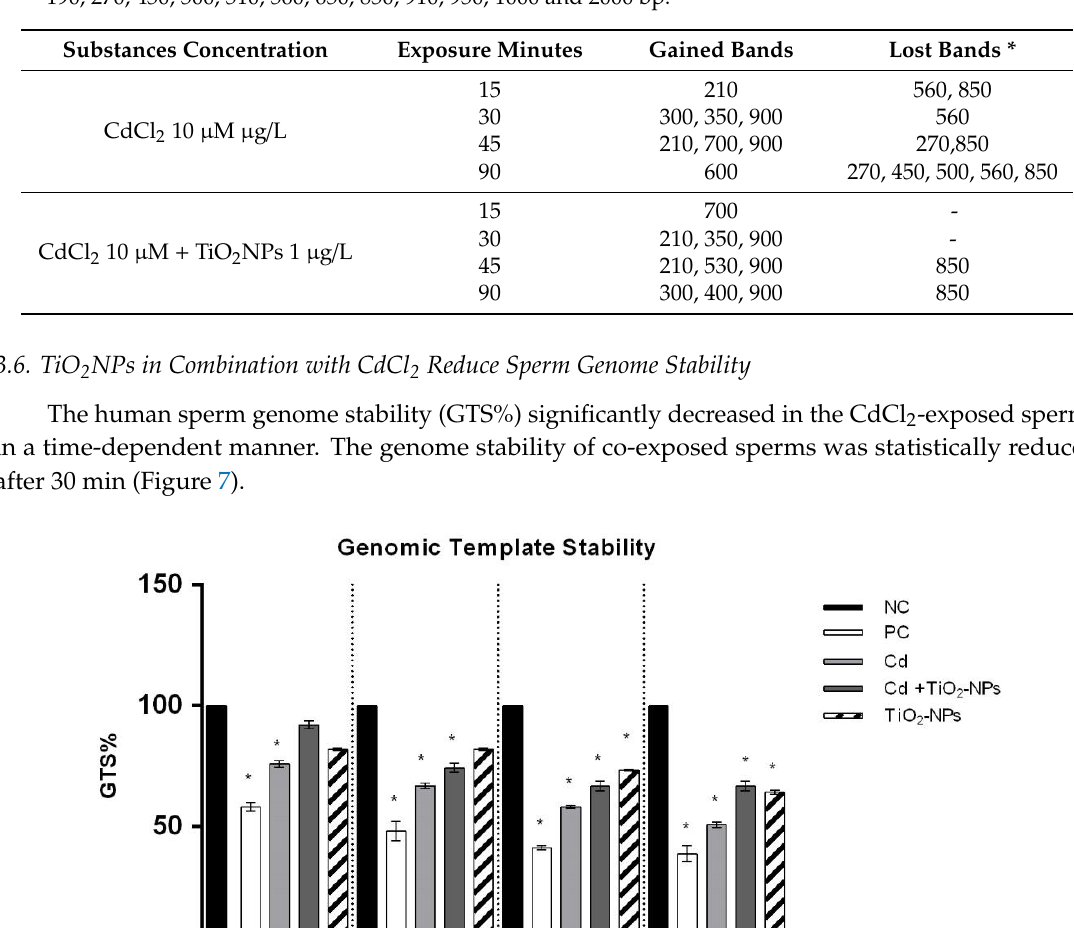
Table 4. Molecular sizes (bp) of appeared and disappeared bands after amplification with primer D11 in human sperm DNA exposed to CdCl 2 and CdCl 2 with TiO 2 NPs co-exposure. * Control bands are at: